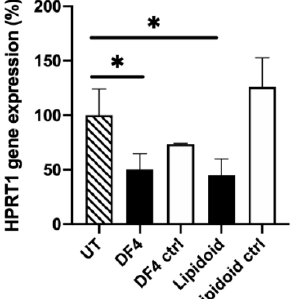
Figure 5. HPRT1 mRNA knockdown in the differentiated primary pRPE cells, 2 days after transfection. Black columns indicate the HPRT1 siRNA (50 nM), the white columns indicate the negative control siRNA (50 nM). HPRT1 mRNA expression was evaluated with a qPCR and normalized to the endogenous GAPDH. Results are presented as the % of remaining gene expression. UT: untreated control cells; DF4: DharmaFect 4; ctrl: negative control siRNA; * indicates statistical significance ( P < 0.05). Data are presented as mean +SD, n = 3.